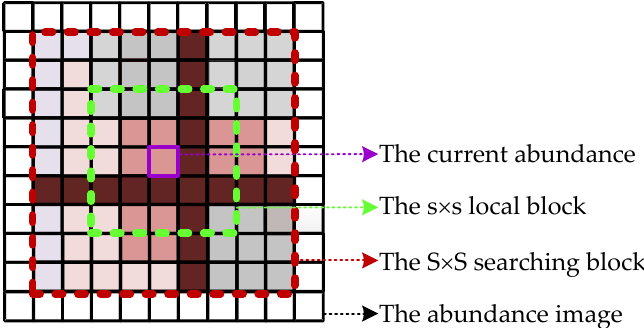
Figure 1. Illustration of basic concept of local block grouping.